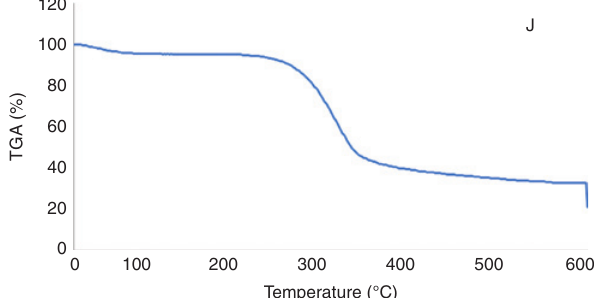
Figure 3: TGA curve of the jute microparticles.